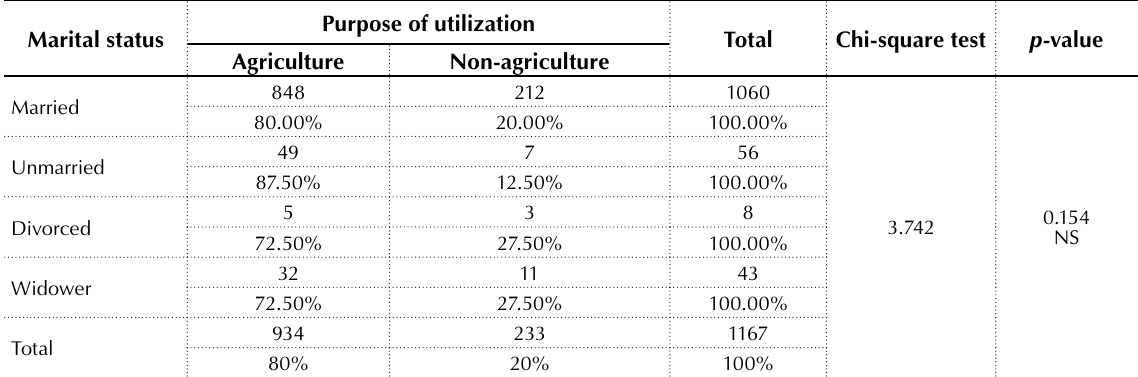
Source: Primary data.